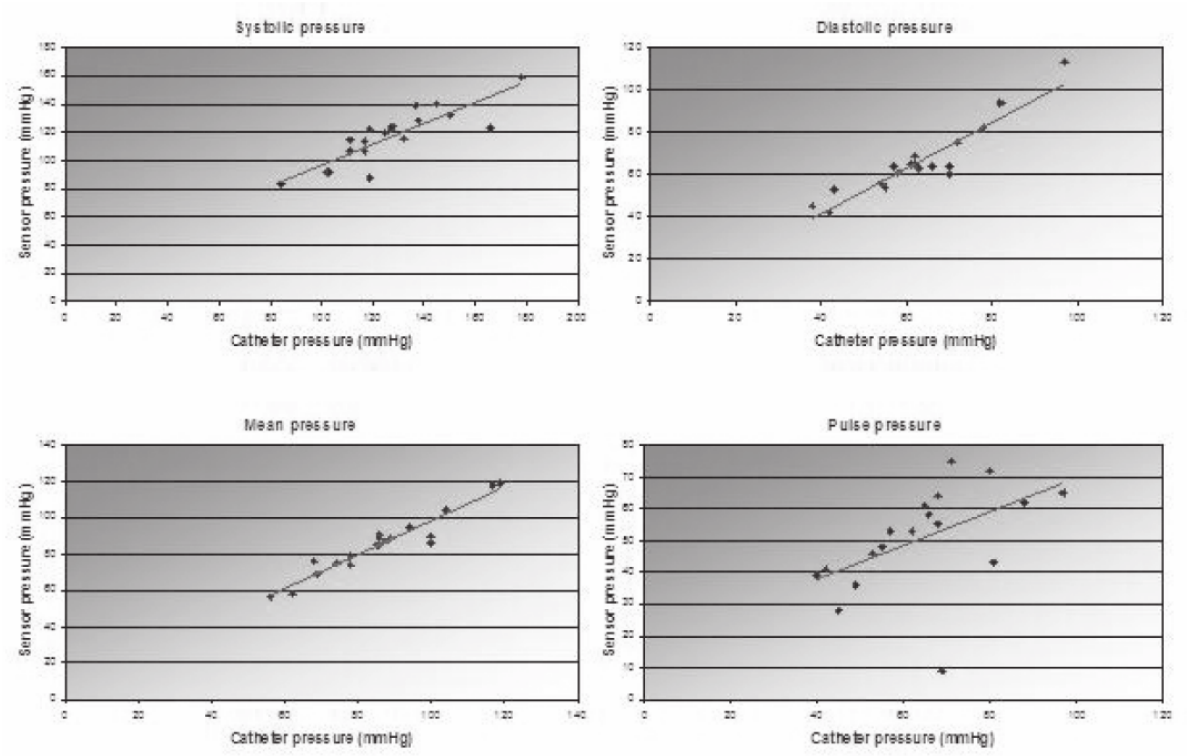
Figure 5 – Scatterplots showing agreement between the Reading 1 pressure measurements of angiographic catheter and pressure